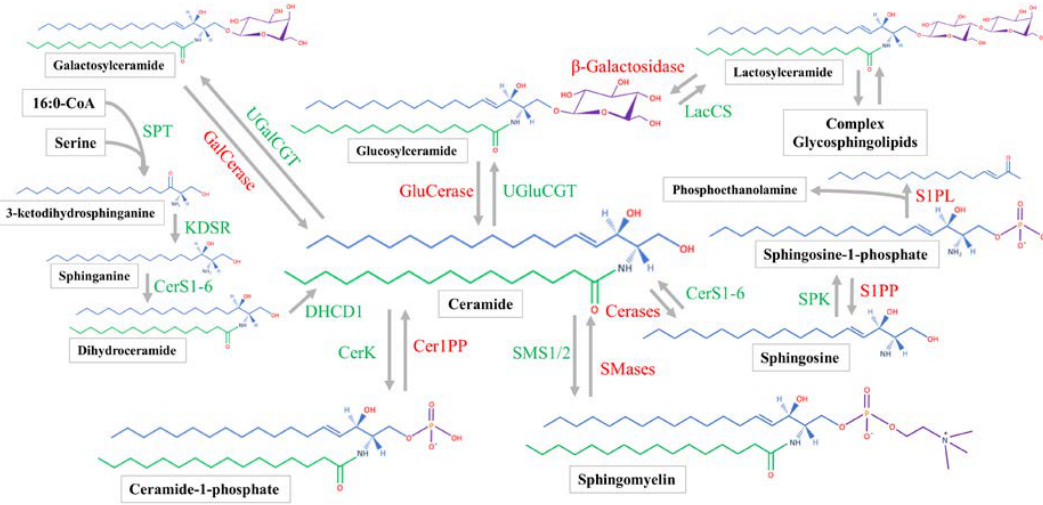
Figure 1. Sphingolipid metabolic pathways and enzymes described in mammalian cells. Serine and palmityl-CoA will be utilized to synthesize 3-ketodihydrosphinganine generating the sphingoid backbone (blue). The subsequent dehydrogenation and acylation will produce dihydroceramide which contains a fatty amide (green). Dihydroceramide can be desaturated to produce ceramide. Ceramide can either be used for catabolism to generate sphingosine and sphingosine-1-phosphate or one of many complex sphingolipids with an additional head group (purple). All synthesis reactions producing complex sphingolipids are reversible, while the sphingosine-1-phosphate catabolic reaction is not. Abbreviations: Cer1PP, ceramide-1-phosphate phosphatase; Cerases, acid-, alkaline-, and neutral-ceramidase; CerK, ceramide kinase; CerS1-6, ceramide synthase 1-6; DHCD1, dihydroceramide desaturase 1; GalCerase, galactosylceramidase; GluCerase, glucosylceramidase; KDSR, ketodihydrosphingosine reductase; LacCS, lactosylceramide synthase; S1PL: sphingosine-1-phosphate lyase; S1PP: sphingosine-1-phosphate phosphatase; SMases, acid-, alkaline-, and neutral-sphingomyelinase; SMS1/2, sphingomyelin synthase 1/2; SPK, sphingosine kinase; SPT, serine palmitoyltransferase; UGalCGT, UDP-galactose-ceramide galactosyltransferase; UGluCGT, UDP-glucose-ceramide glucosyltransferase.